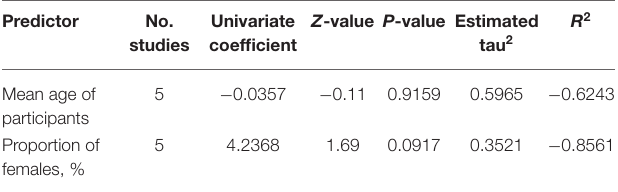
TABLE 2 | Meta-regression analysis on the sources of heterogeneity.